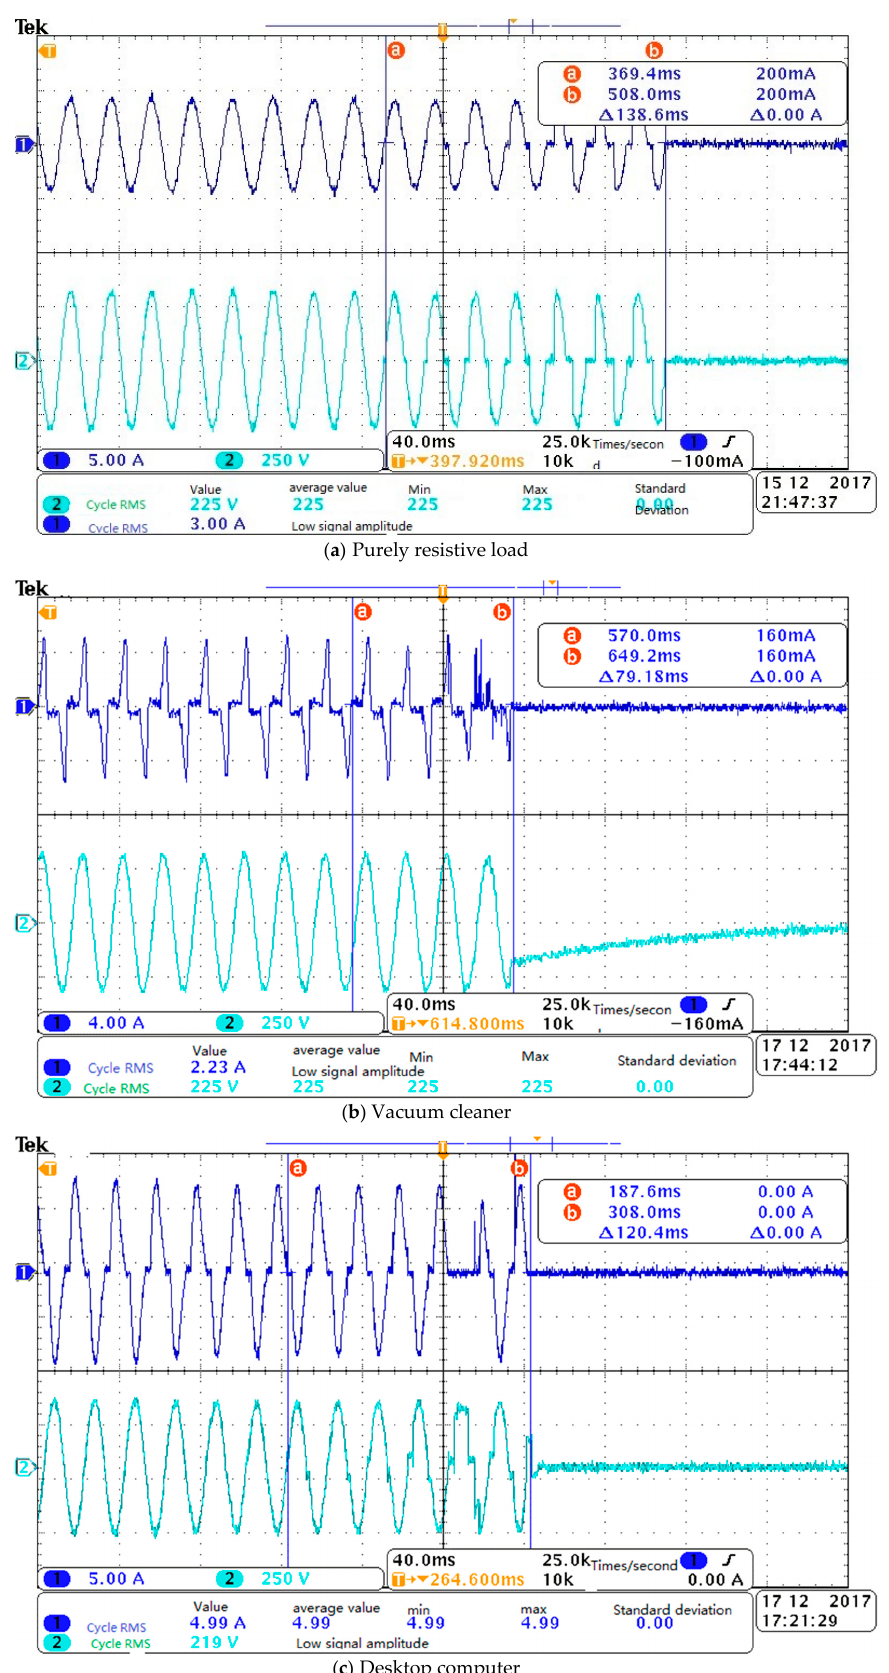
Figure 13. Series arc fault test.